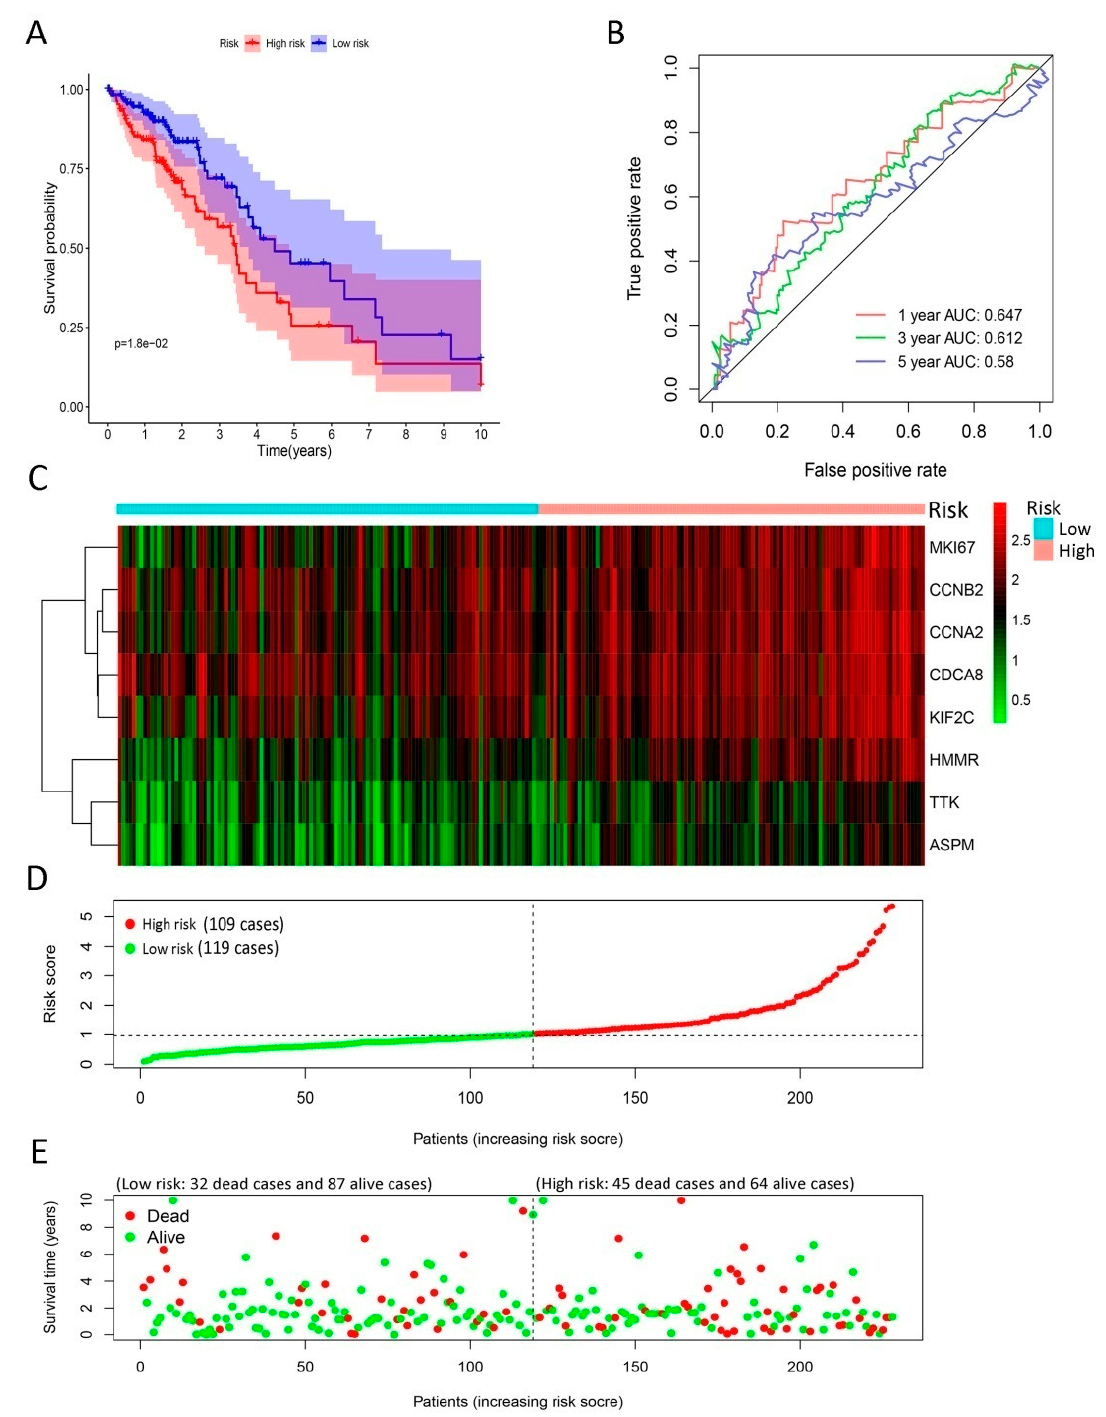
Figure 5. Validation of gene signature in the testing group. ( A ) Survival curve of high- and low-risk groups separated by gene signature. ( B ) ROC analysis for survival rate predicted by gene signaturefor 1-, 3-, and 5-year follow-ups. ( C – E ) Expression heatmap of eight signature genes ( C ), risk score distribution ( D ), and survival status of patients ( E ). The risk score based on gene signature in the testing group also appears to be correlated with survival status for lung cancer patients in low- and high-risk groups, which was consistent with that in training group. Table 4. Univariate and multivariate Cox regression analysis for risk score on overall survival of patients with LUAD.